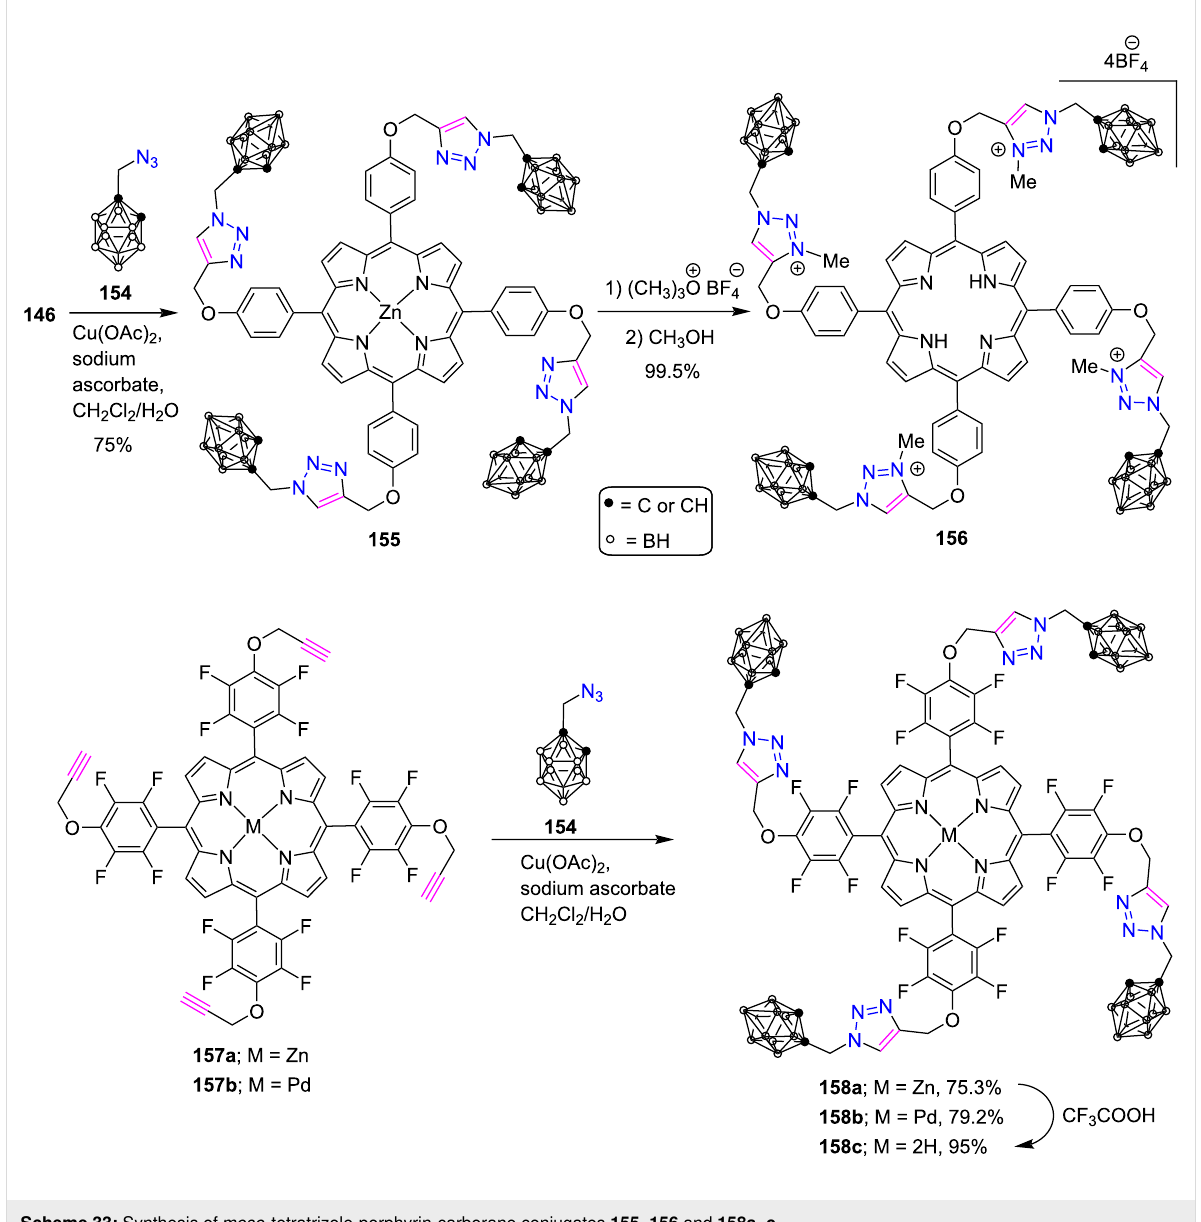
Scheme 33: Synthesis of meso -tetratrizole-porphyrin - carborane conjugates 155 , 156 and 158a – c .